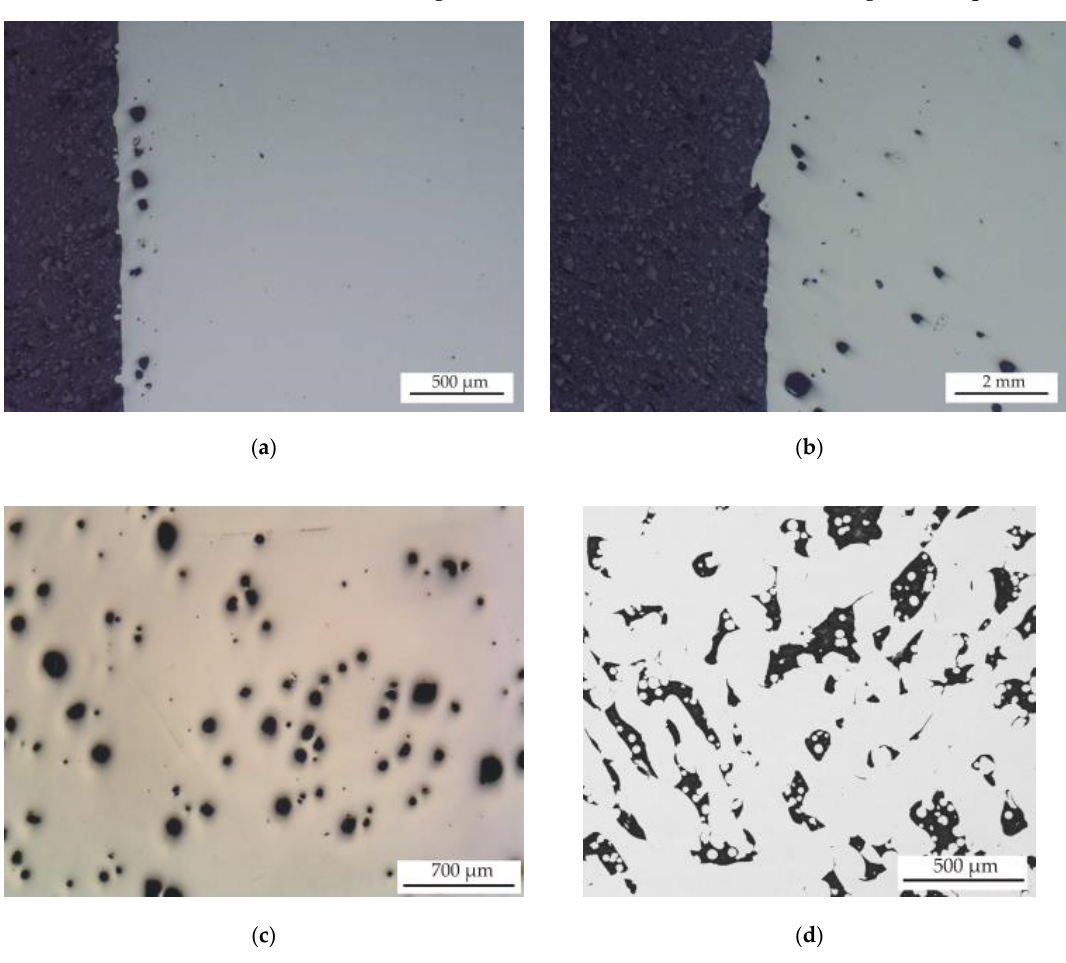
Figure 13. ( a ) OM image of sample 2 (scanning speed: 650 mm / s); ( b ) OM image of sample 5 (scanning speed: 400 mm / s); ( c ) OM image of sample 13 (scanning speed: 400 mm / s); ( d ) BSEM image of sample 4 (scanning speed: 1200 mm / s). All samples are after SLM and in a polished state.